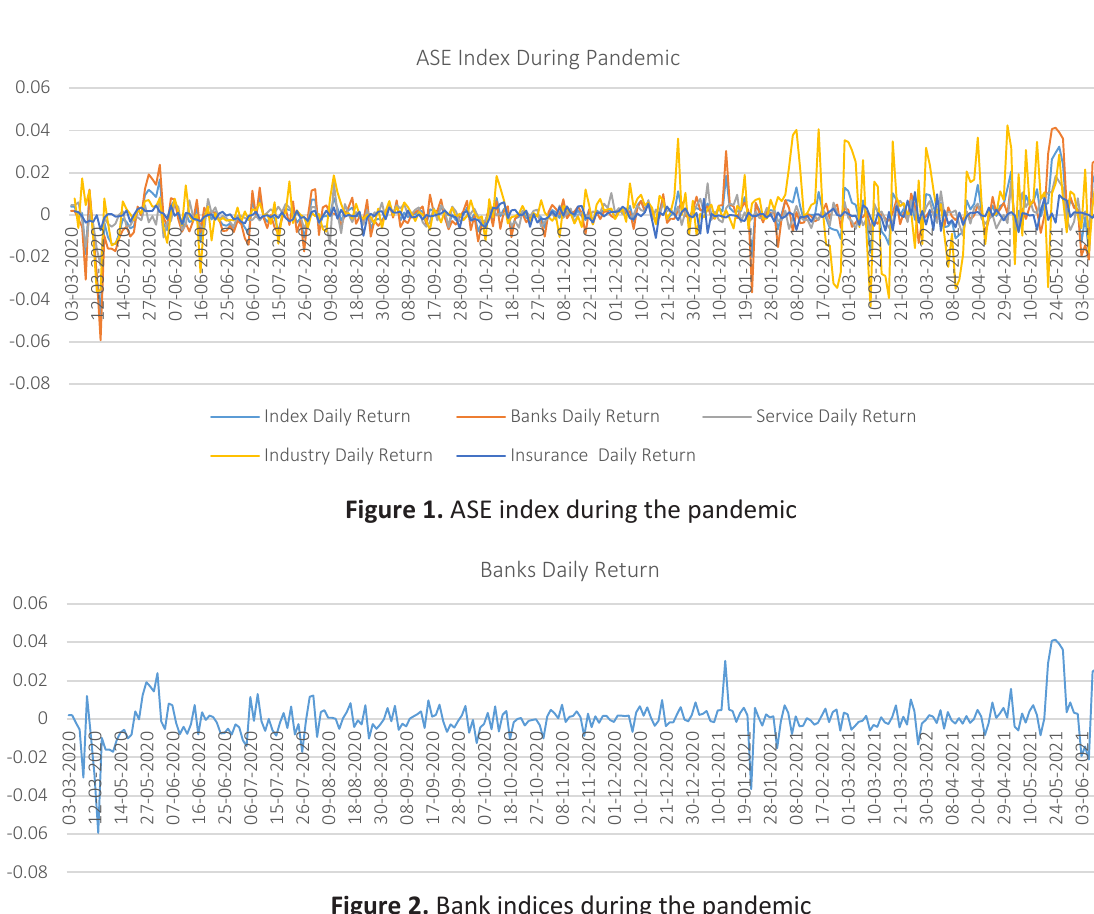
Figure 2. Bank indices during the